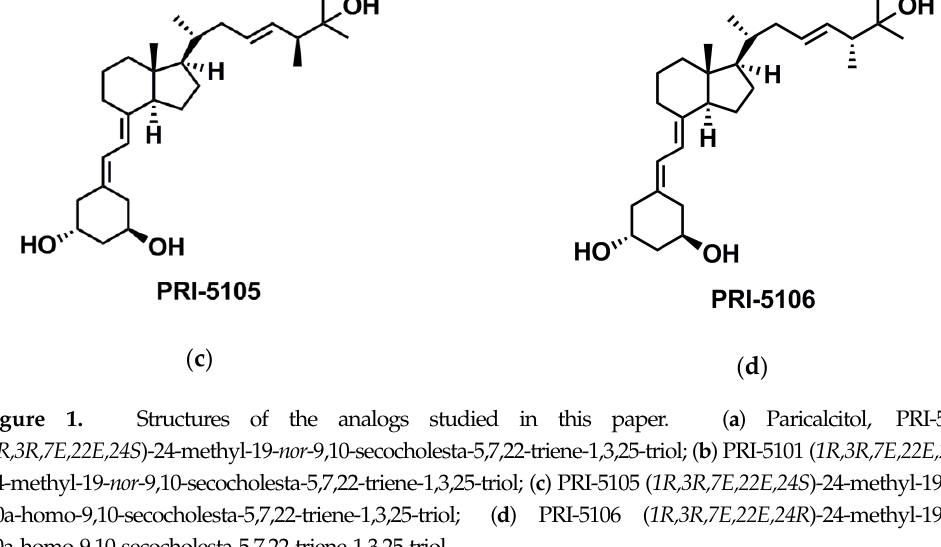
Table 1. A ffi nities of the compounds to recombinant Table 1. Affinities of the compounds to recombinant VDR.